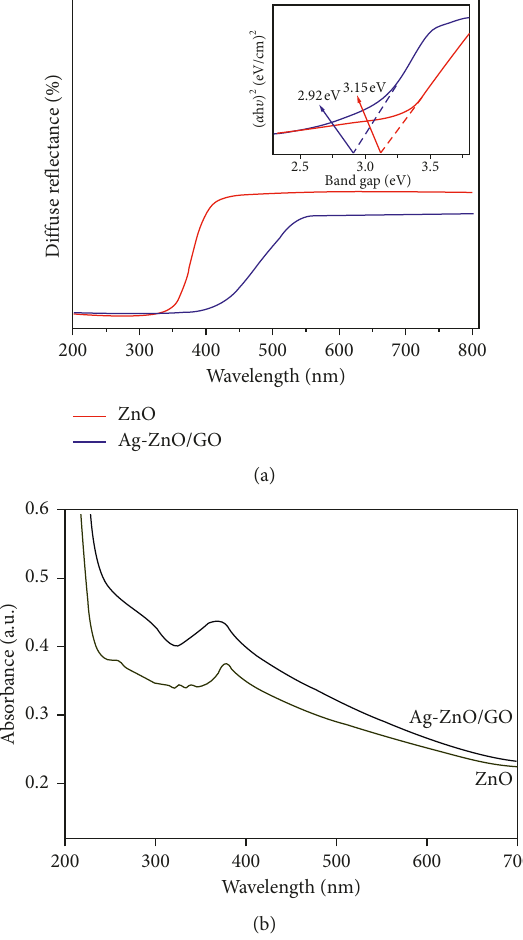
Figure 5: UV-VIS reflectance spectra and band gap of synthesized materials.